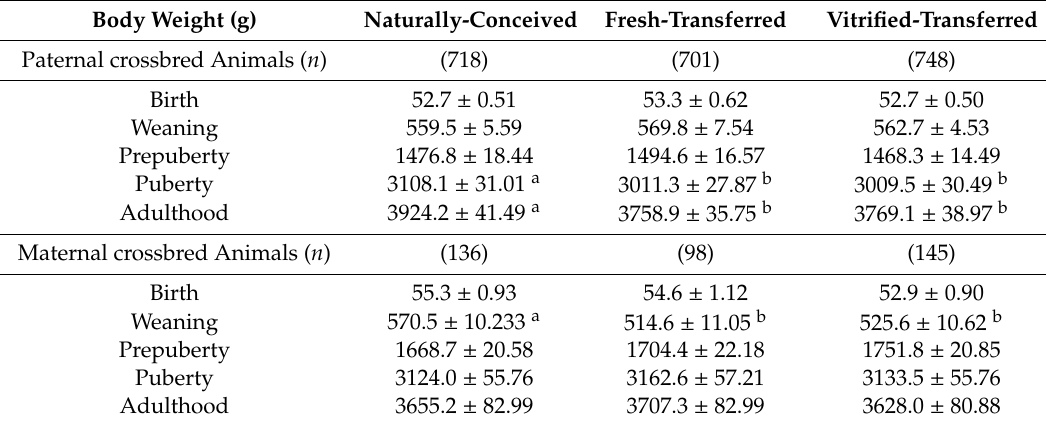
Table 1. Bodyweight comparison between naturally conceived (NC), fresh-transferred (FT), and vitrified-transferred (VT) progenies of the paternal crossbred generation and maternal crossbred